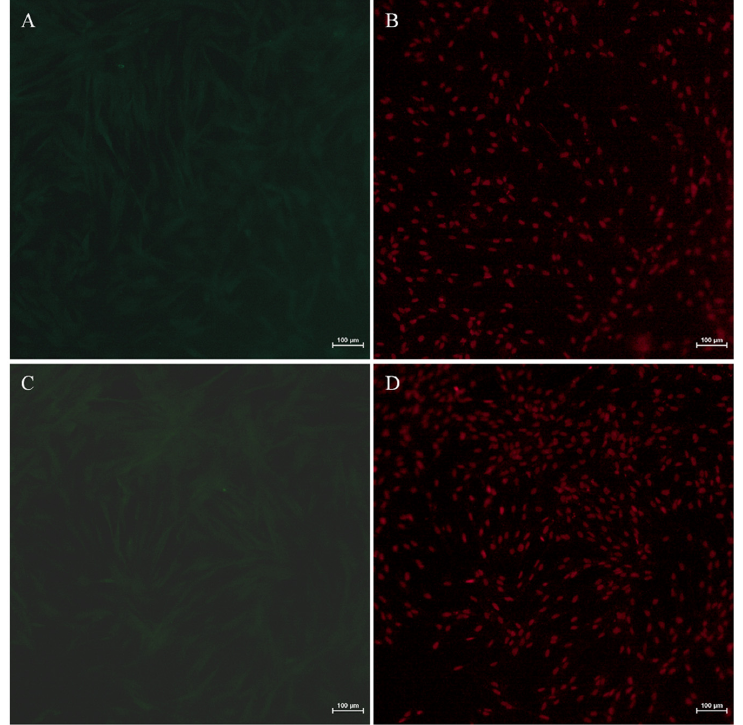
Figure 5. The YTO2 Cells immunostained with pre-immune serum as a negative control. The signals were visualized by TSA green staining (green) ( A , C ) and nuclei were stained red by propidium iodide (PI) ( B , D ). No signal was observed in YTO2 cells immunostained with both mouse serum ( A , B ) and rabbit serum ( C , D ).